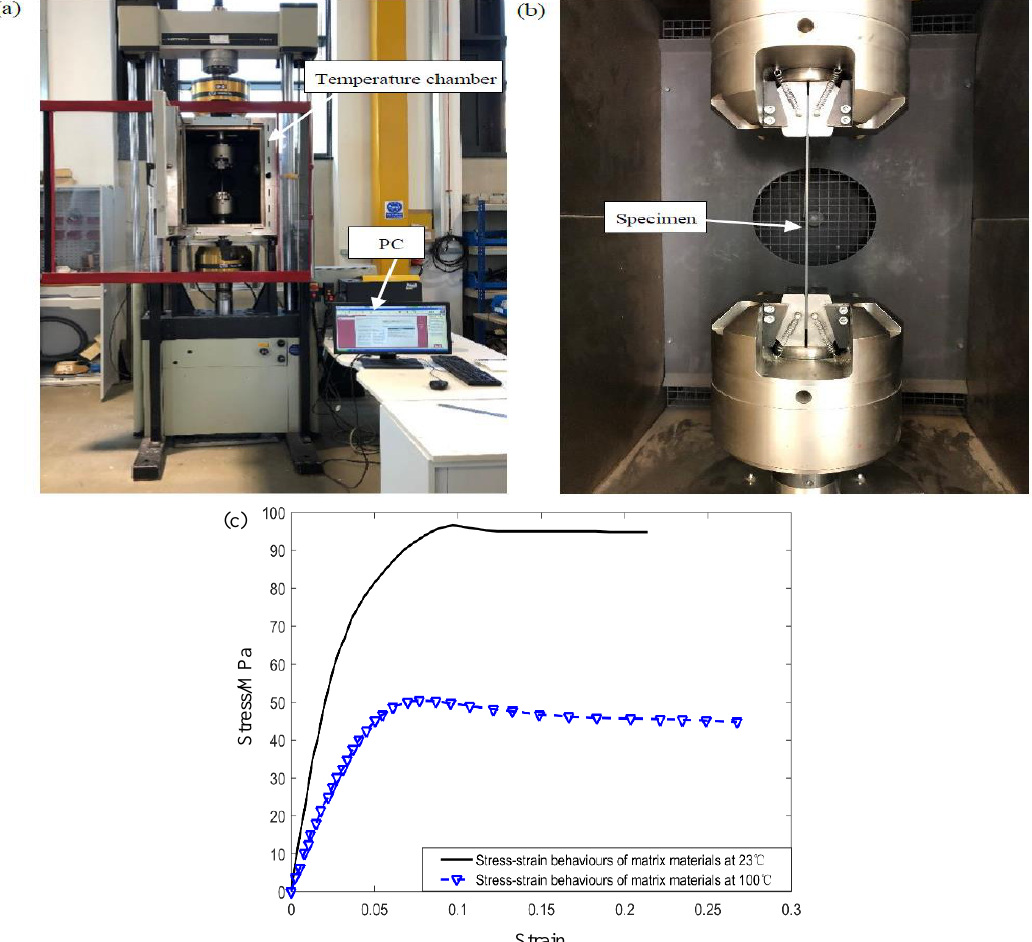
Figure 2. Mechanical behaviors test at room and elevated temperatures. ( a ) MTS. ( b ) Fixture and specimen. ( c ) Matrix materials at room and elevated temperatures.